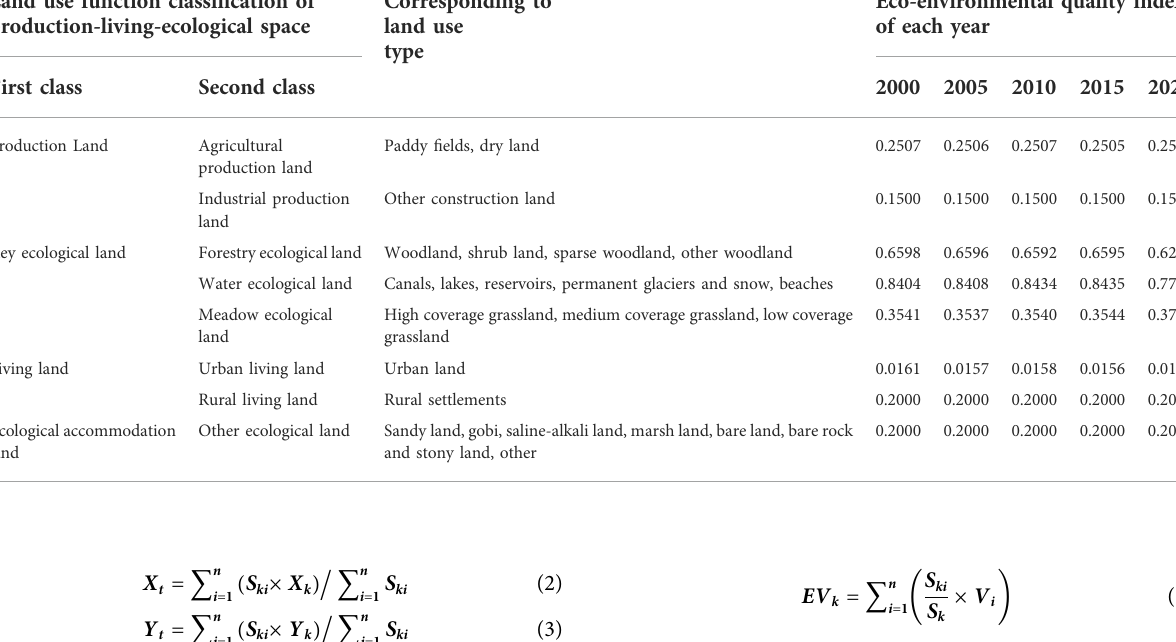
TABLE 1 Land use function classi fi cation system and eco-environmental quality index of the Tarim River Basin. Land use function classi fi cation